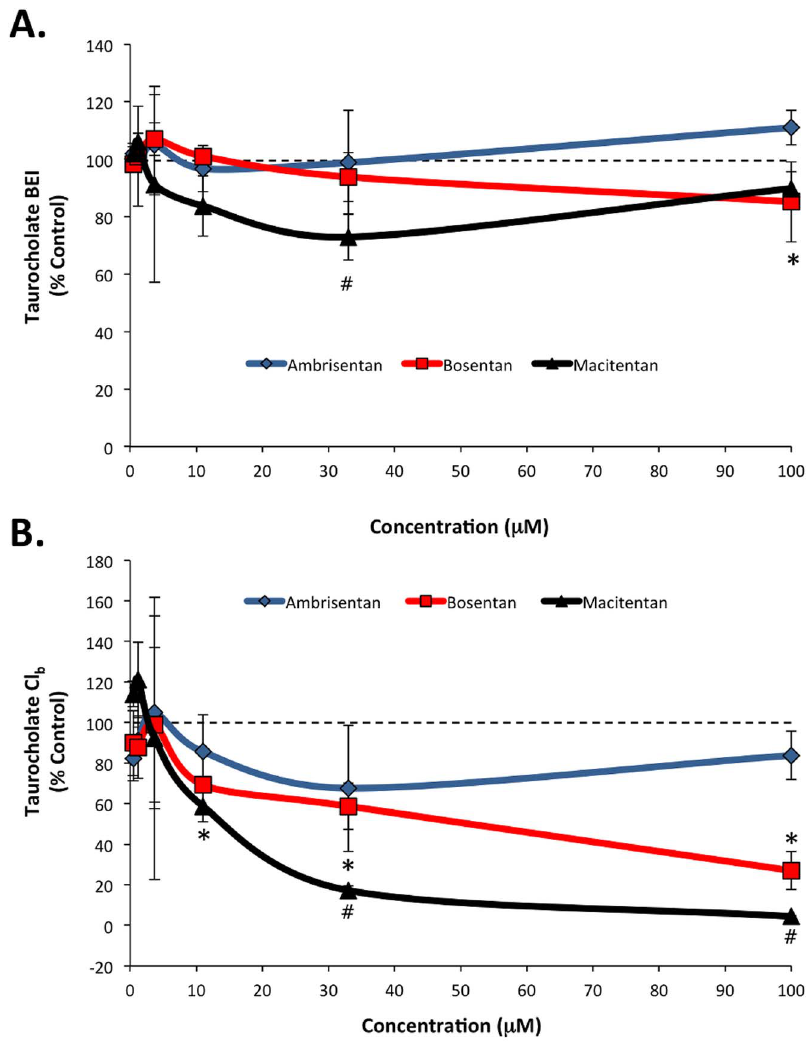
Figure 3. d 8 -Taurocholate (d 8 -TCA) biliary efflux (A) and clearance (B) in sandwich-cultured human hepatocytes exposed to ambrisentan, bosentan, and macitentan. The biliary excretion index (BEI) of d 8 -TCA was largely unaffected by the test ERAs. Bosentan and macitentan treatment resulted in dose-dependent reductions in biliary clearance (Cl b ) of d 8 -TCA. Data presented as mean ( 6 SD) expressed as percent of control treated; n=3 donors; *P , 0.05 bosentan vs. control; # P , 0.05 macitentan vs. control.